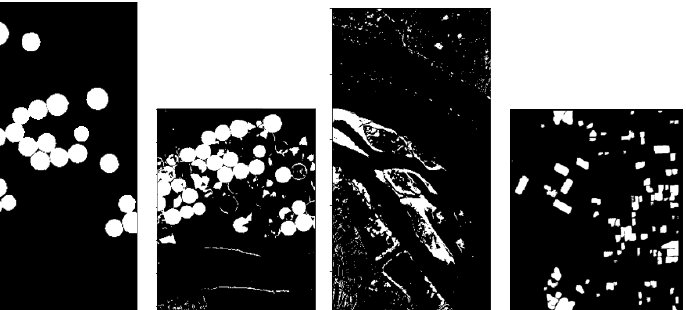
Figure 10. The obtained final binary change maps. From leftmost to rightmost: Hermiston , USA , River , and Bay Area datasets.